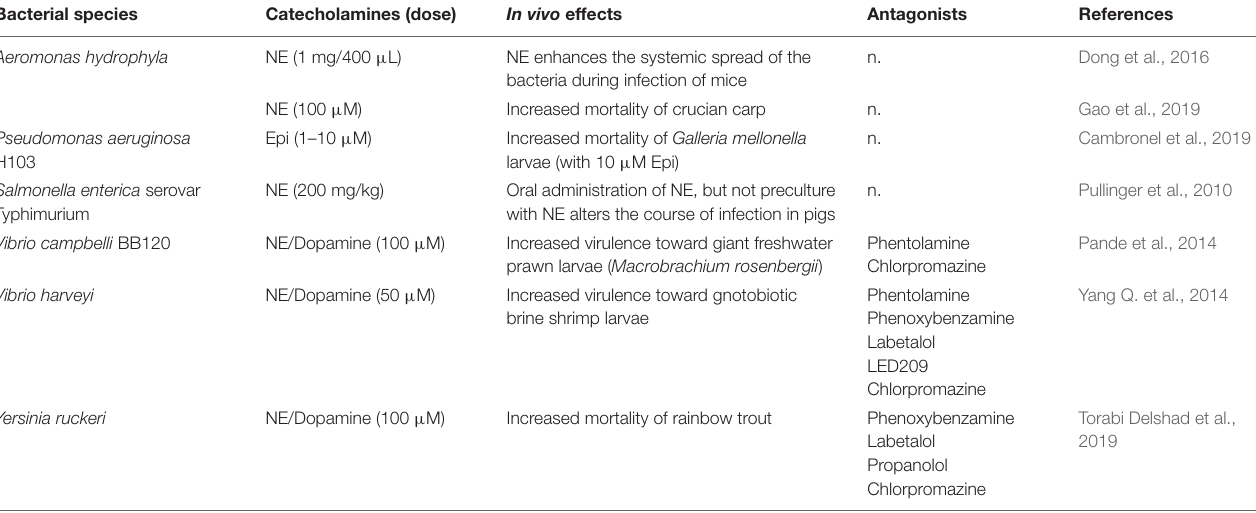
TABLE 6 | In vivo bacterial effects in presence of